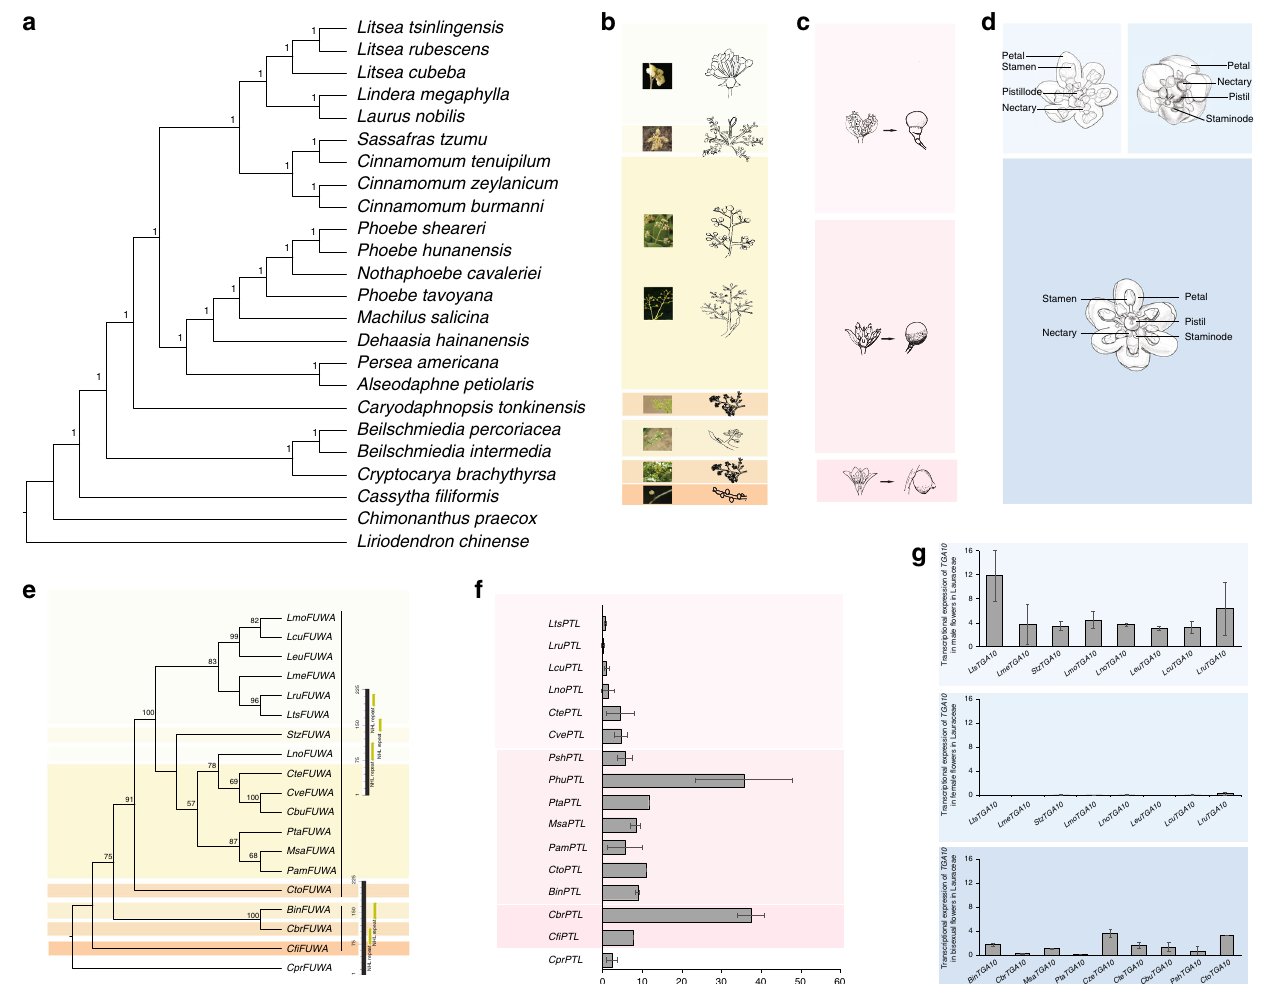
Fig. 3 The evolution of fl oral structures in Lauraceae. a Phylogeny of Lauraceae based on a concatenated sequence alignment of 275 single-copy gene families for 22 species in the Lauraceae. b The variable panicles in Lauraceae (from bottom to up): spikes in Cassytha , spikelike panicles in the Cryptocarya group, cymoses panicles in the Alseodaphne - Phoebe clade and Cinnamomum , pseudo-umbel in Sassafras , and umbels in the Laurus - Litsea clade. c Perianth tube turbinate or suburceolate present in Cryptocarya group and Cassytha . Caryodaphnopsis and Alseodaphne - Phoebe clade appear broadly conical and short perianth tube. Perianth tubes are campanulate, short to nearly absent in the Cinnamomum - Litsea clade. d The Cinnamomum - Litsea clade has unisexual fl owers and the other species in Lauraceae have bio-sexual fl owers. e The phylogenetic tree of FUWA homologs in different Lauraceae species. f PTL expression in the fl ower buds of Lauraceae species. The PTL expression level was noted as being consistent with the variation of perianth morphology in Lauraceae. PTL exhibited a higher level of expression in the fl ower buds of the basic group lineage ( Cryptocarya group), which presented an abscission of the perianth tube from the perianth tube encapsulated in fruits. PTL had a lower level of expression in the Litsea - Cinnamomum clade, where the fruit receptacle developed from the perianth tube. g TGACG motif-binding protein family member TGA10 has higher transcriptional expression level in male fl owers than that in female fl owers from eight unisexual species representing four genera, and TGA10 also has higher expression lever in male fl owers comparing with that in bisexual fl owers from nine bisexual species representing six genera of Lauraceae. Source data underlying a , e – g are provided as a Source Data fi